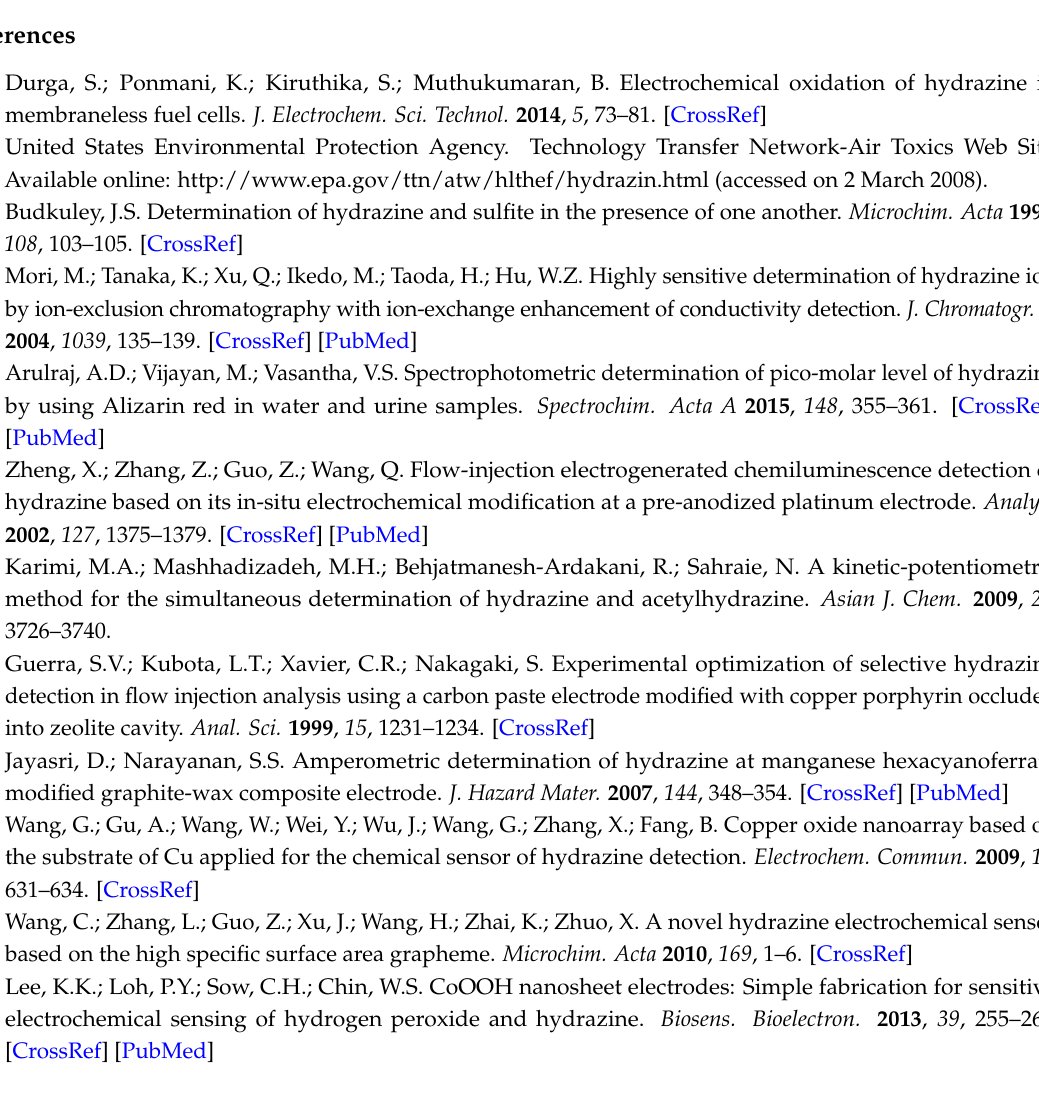
Figure S1. The detail information of cyclic voltammograms in tap water solution with additional